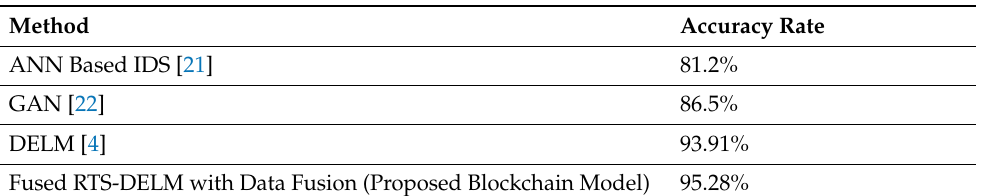
Table 3. Comparison of results of the proposed data fusion technique of decentralized smart home network based on Fused RTS-DELM with the